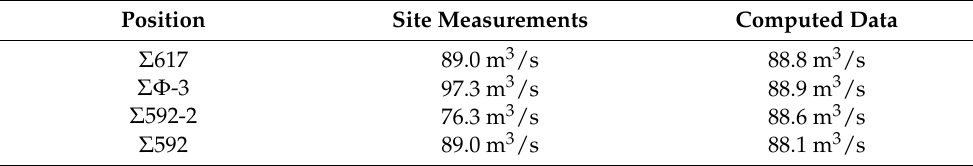
Table 3. Comparison between real data of air quantity and corresponding software results.